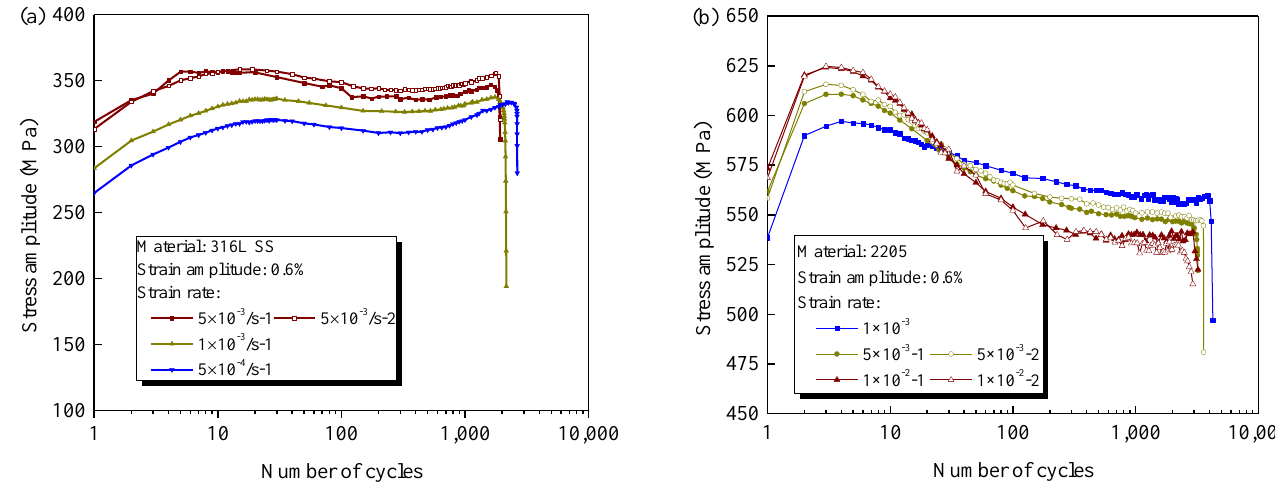
Figure 6. Cyclic stress amplitude for ( a ) 316L and ( b ) 2205 under different strain rates with a constant strain amplitude.